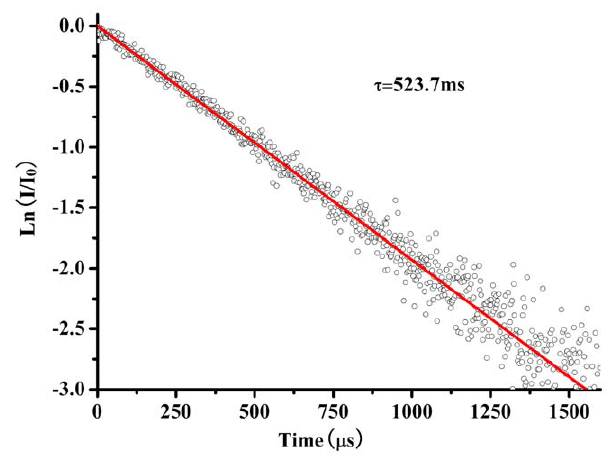
Figure 6. Lifetime decay curve of Yb 3 + :KBaGd(MoO 4 ) 3 crystal at room temperature.